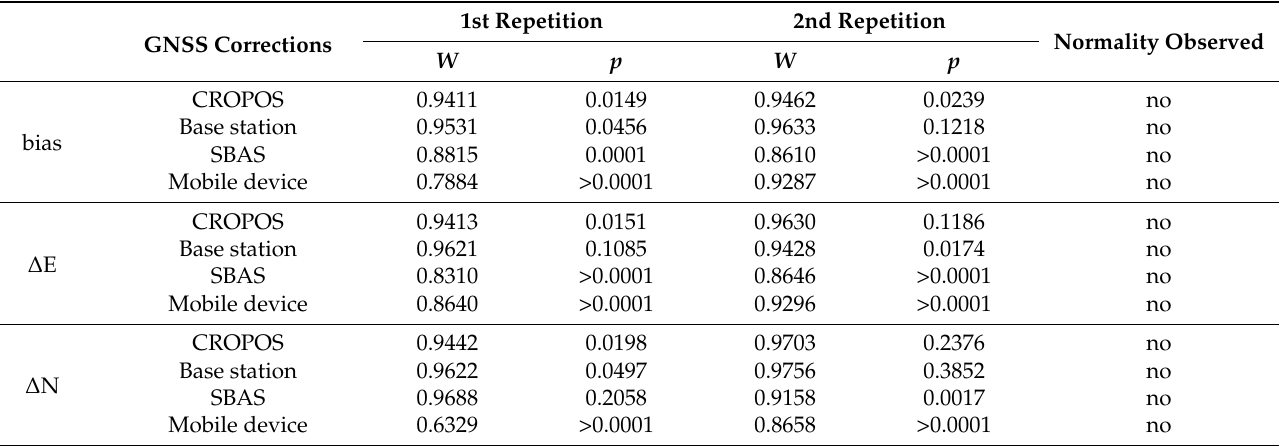
Table 3. Shapiro-Wilk normality test results for GNSS positioning bias.